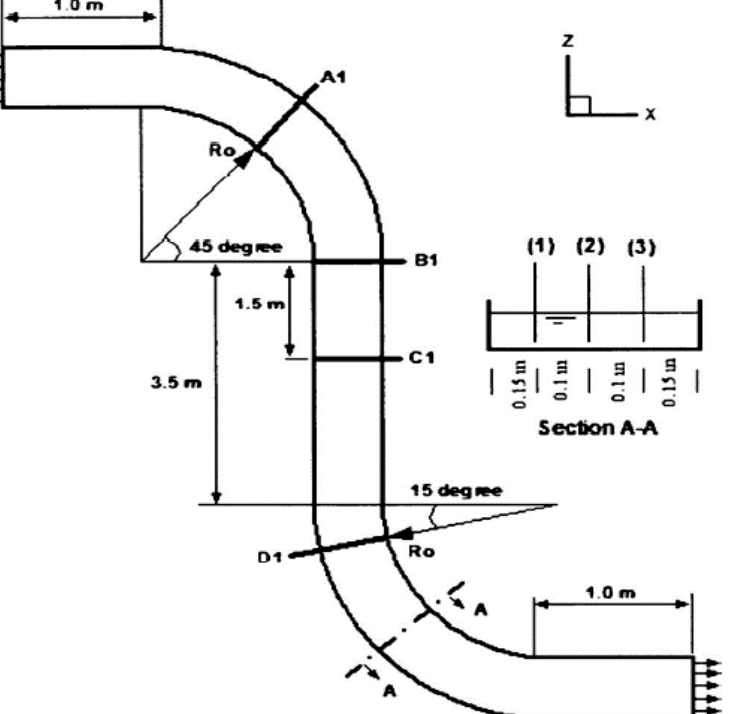
Figure 5. S-shaped channel used in Ghanmi’s (1999) [57] study from top view and characteristics of sections, which are used to compare calculated and measured data (Reproduced from Khosronejad et al. (2007) [20] with permission from ASCE) .